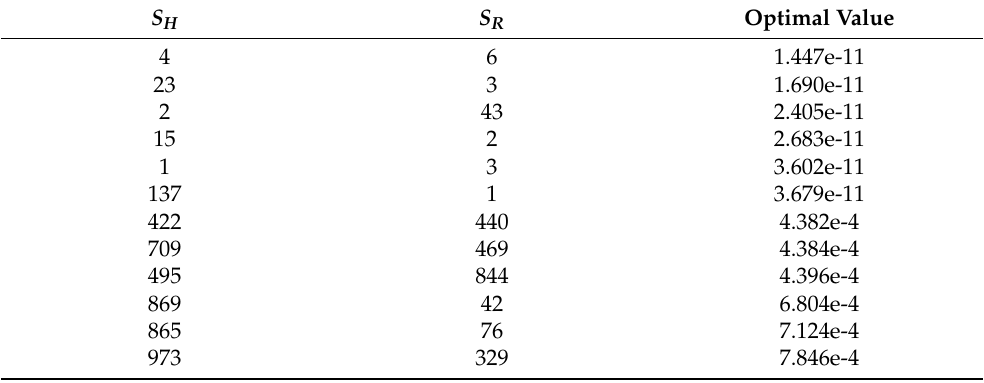
Table 14. The partial results of the relationship between the speed control constant and the optimal value of the objective function calculated by the OMO algorithm.